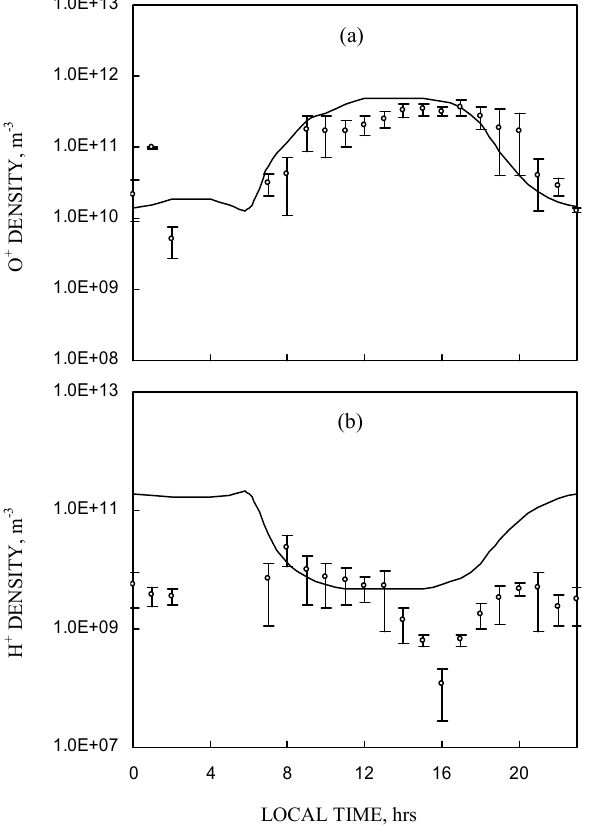
Fig. 5. Same as in Fig. 4 for 10 ◦ N geomagnetic